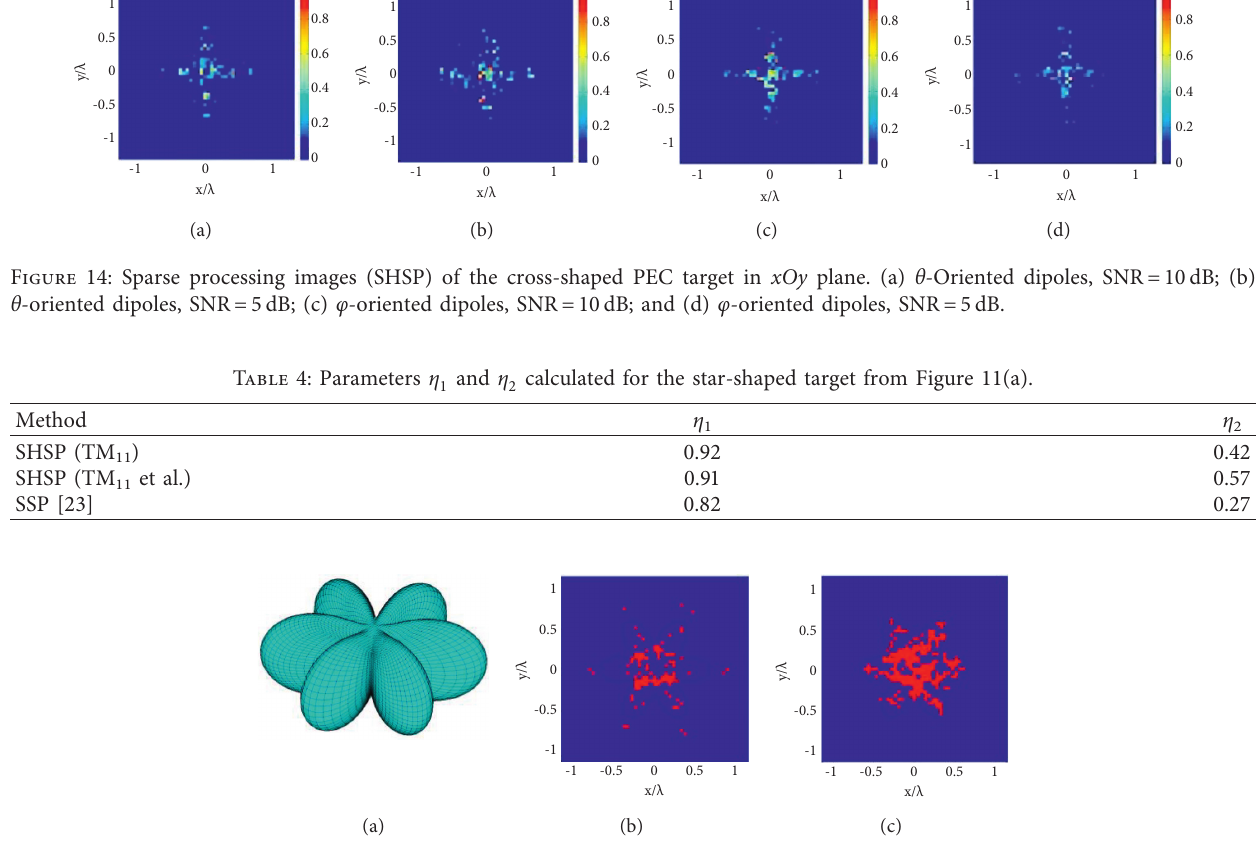
Figure 15: (a) Star-shaped object. Reconstruction of the star-shaped object in xOy plane, obtained using f -oriented dipoles, SNR � 5dB: (b) SSP and (c)